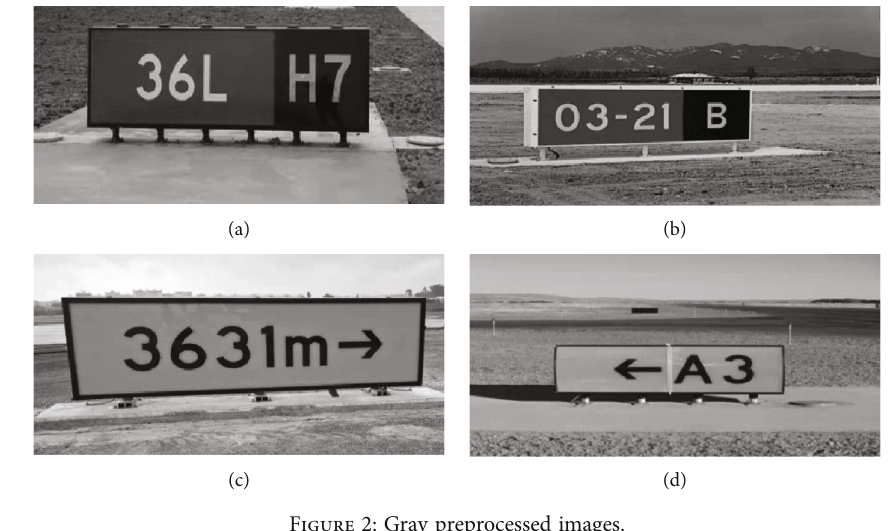
Figure 2: Gray preprocessed images.